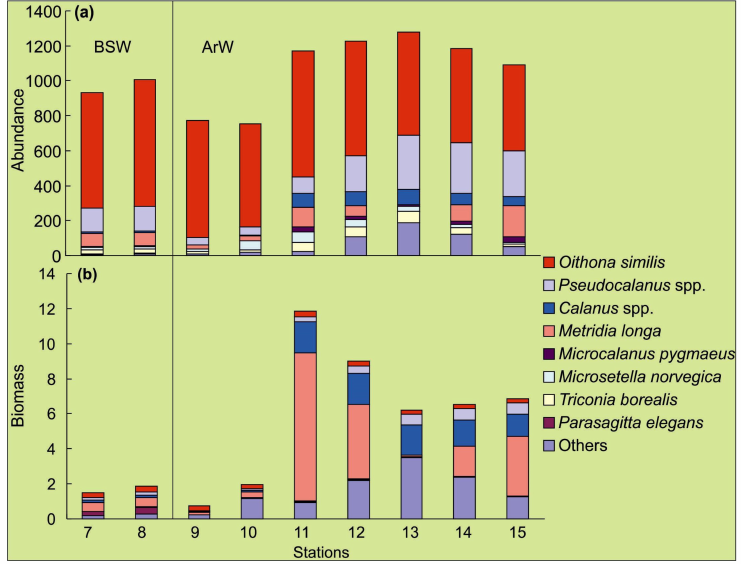
Figure 3. Zooplankton composition, abundance (( a )—individuals · m − 3 ) and carbon biomass (( b )—mgC · m − 3 ) in the 0–100 m layer in the northeastern Barents Sea, in October 2020. Water masses: BSW—Barents Sea Water, ArW—Arctic